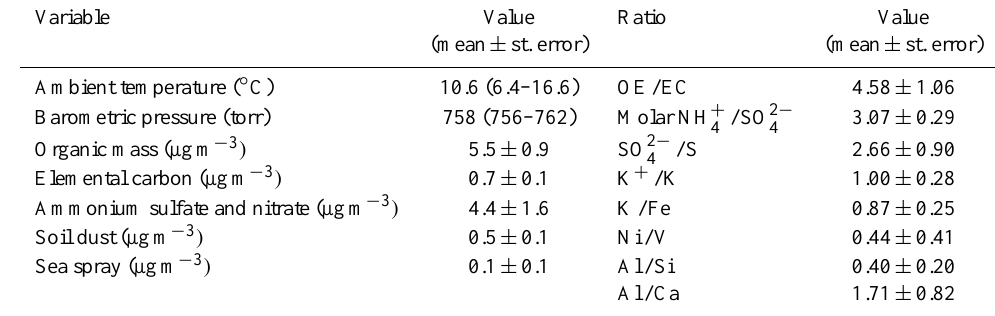
Table 1. Major aerosol types and diagnostic ratios of PM 2 . 5 chemical species in Little Rock, Arkansas during the study period. Variable Value Ratio Value (mean ± st.